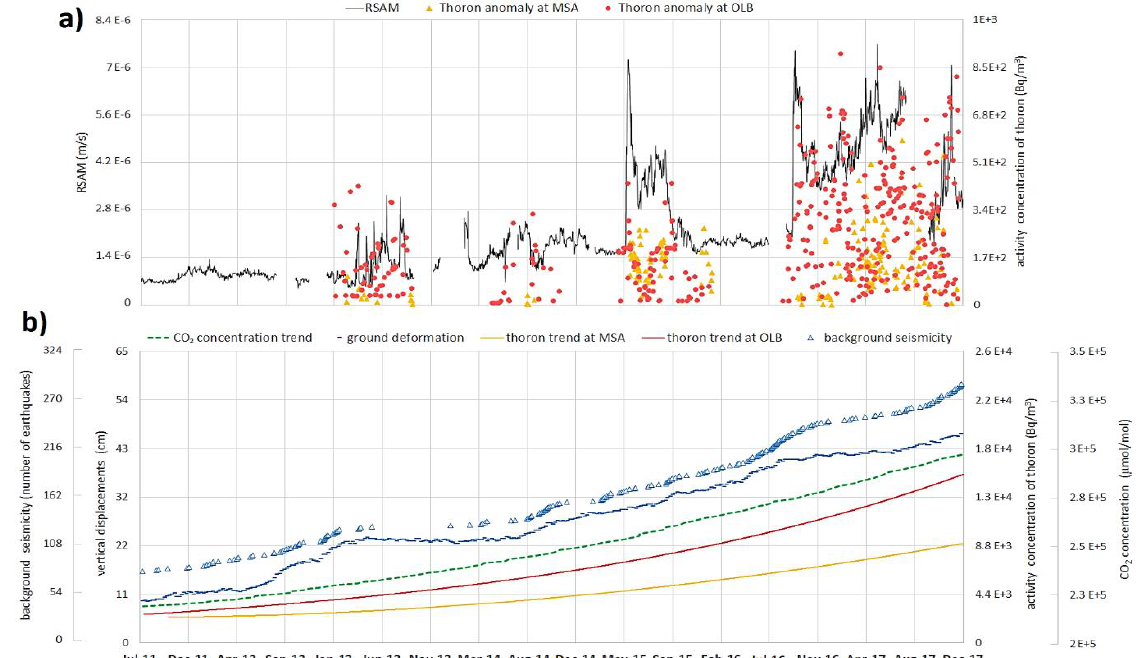
Figure 4. ( a ) Thoron residuals (anomalies) at OLB and MSA sites compared with the fumarolic tremor (RSAM) registered at Pisciarelli fumarole. ( b ) Thoron trends at OLB and MSA sites compared with the maximum vertical displacement at Campi Flegrei, the background seismicity (i.e., the cumulative number of days with earthquakes since 2000) and the hydrothermal CO 2 flux trend from Pisciarelli vent. The accuracy of the measured data, i.e., the error bars, is an approximately constant 4%.